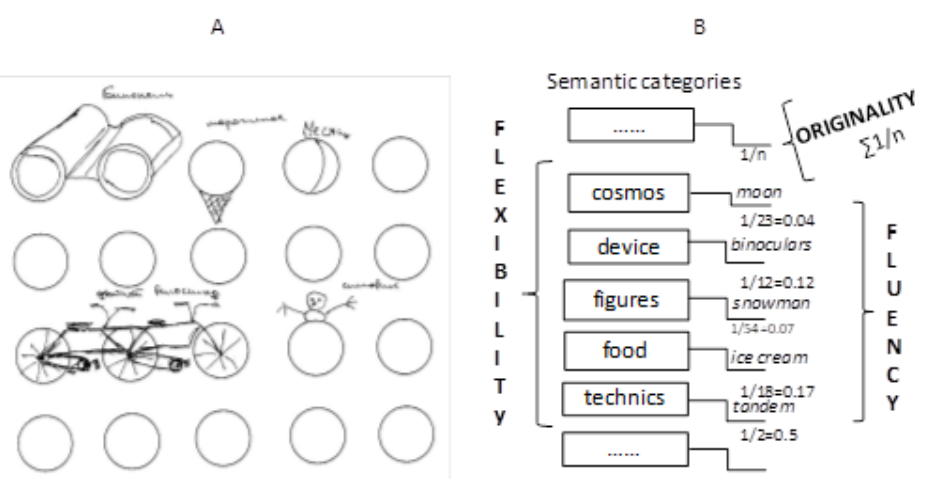
Figure 1. ( A ) An example of a fulfilled RF test; ( B ) The creativity indicator calculation scheme in the Figure 1. ( A )An example of a fulfilled RF test; ( B )The creativity indicator calculation scheme in the software for the same example. software for the same example.